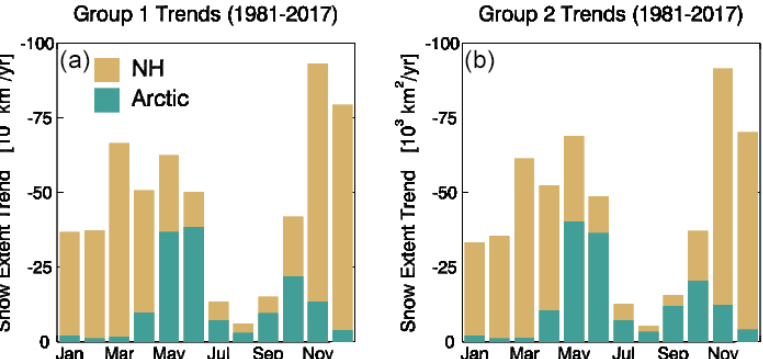
Figure 8. Snow extent trends over 1981–2017 from multi-product groups outlined in Table 1: older product versions (a) and updated product versions (b)